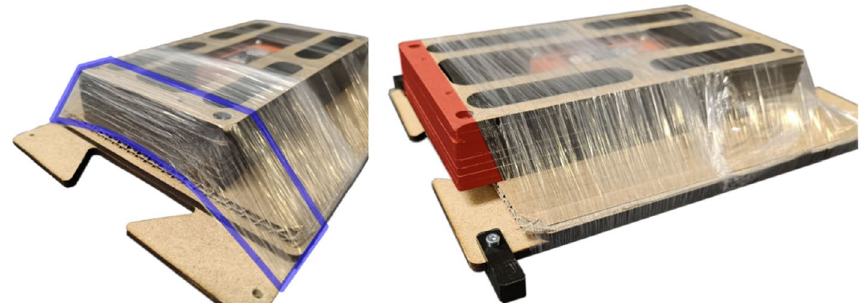
Fig. 14 proper (left) and improper (right) wrapping of the package